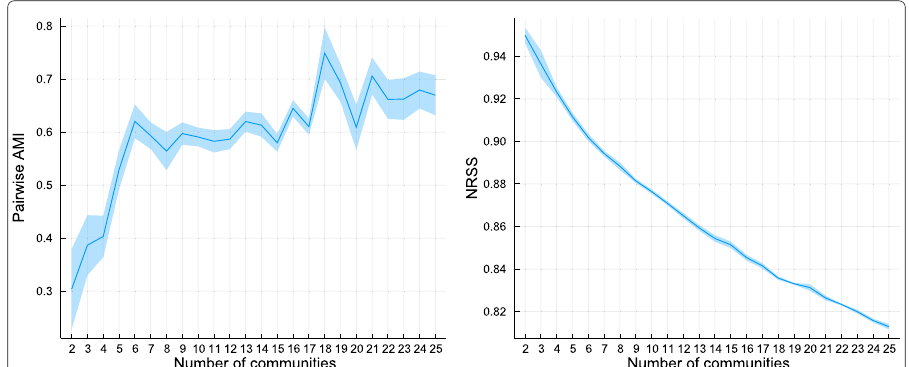
Fig. 9 npm adjusted mutual information against components. The pairwise adjusted mutual information of the community-node membership across repeated decompositions. 1 is a perfectly stable assignment to communities; 0 is perfectly random. The shaded area corresponds to twice the standard error of the mean above and below the